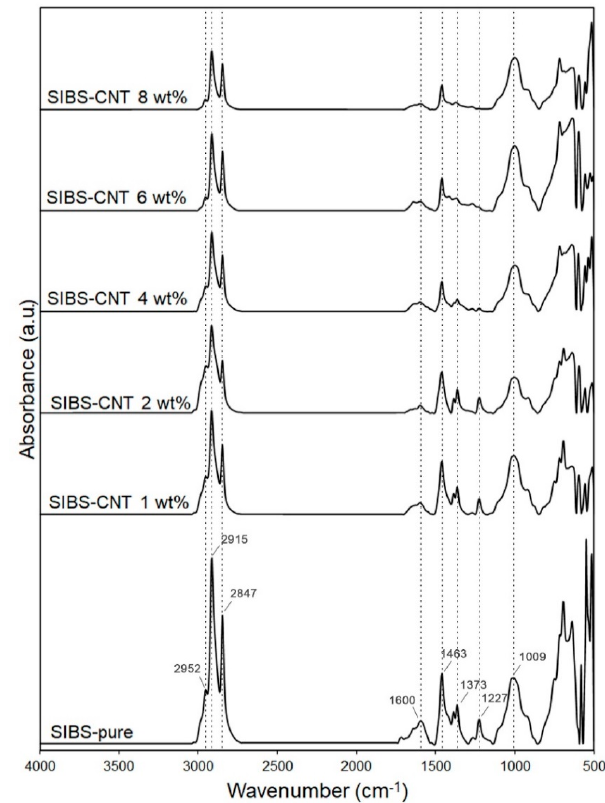
Figure 3. FTIR spectra of the intact and carbon nanotube (CNT)-modified SIBS.